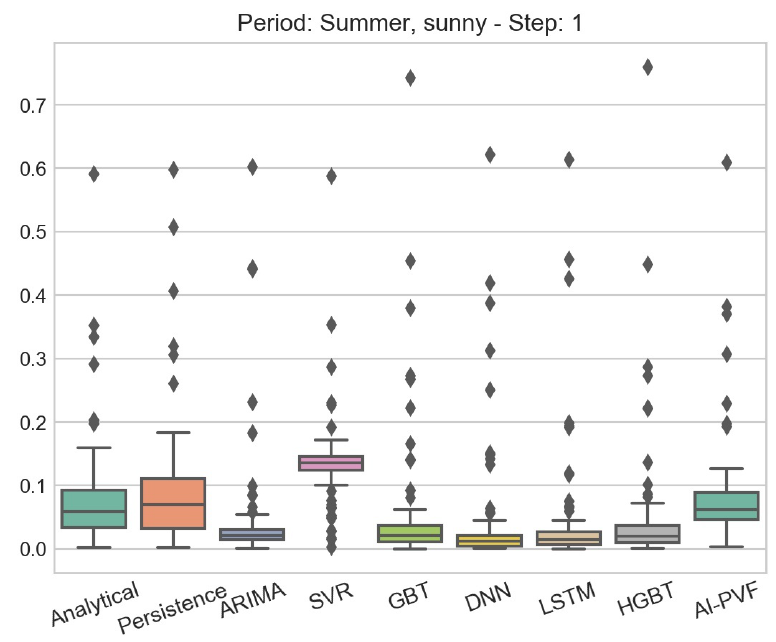
Figure 4. Boxplot of residuals for all PV power generation forecasting models. The data partition examined in this case is the sunny days subperiod of the summer season and the forecasting horizon is 1 step